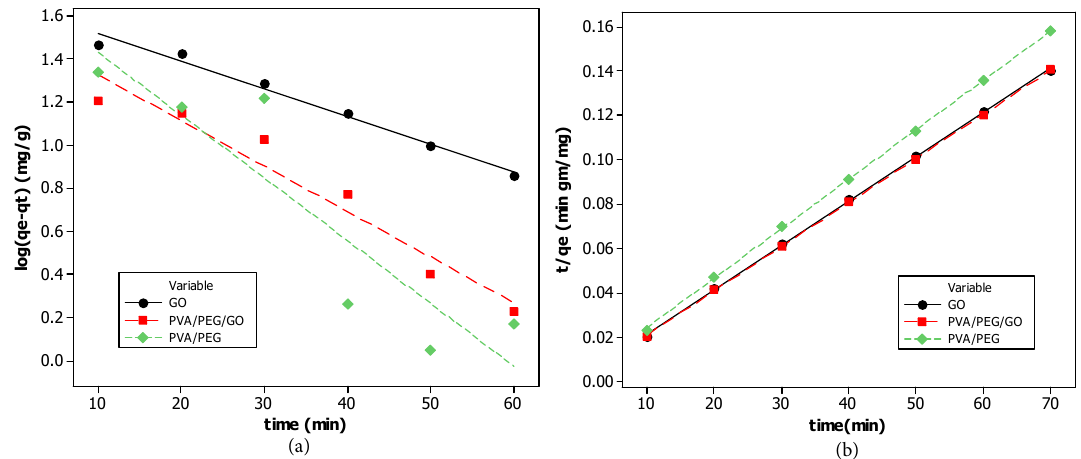
Fig. 9: (a) Pseudo first order model, (b) pseudo second order model for GO, PVA/PEG/GO, PVA/PEG at initial concentration of Cu 2+ = 500 mg l –1 , dosage of GO 100 mg l –1 , initial solution pH